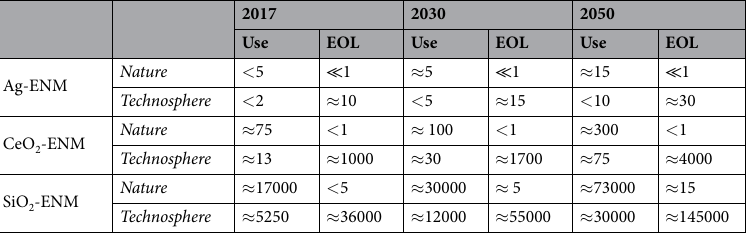
Table 2. Ag-, CeO 2 -, and SiO 2 -ENM release in t/a to nature (waters, soils, air) and the technosphere (landfills, recycling, waste incineration, and sewage treatment). Shown are rounded and simplified modal values (most frequent Monte Carlo outputs) for use and end of life (EOL) release. For CeO 2 results, see also Fig. 2 and, for specific flow charts, Figs S2–S4 in the Supplementary